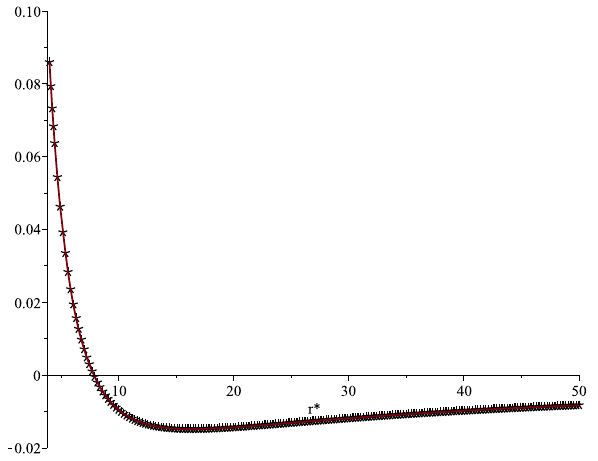
Fig. 9 Plot of the effective potentials (28) (asterisk symbol) (Schwarzschild case) and (30) (solid line) in the massive case when L = 3, H = 0 . 1 and ξ = 1 . 0. This choice of H gives rise to a scaling factor h of the same order as h B 1 = 3 . 89 × 10 − 11 kpc in √ = 9 + 3 [58]. The minimum is located at r ∗ 6 ≈ 16 . 35 where min ) = − 0 . 0147 and V ( r ∗ ) = − 0 . 0147. Both potentials V ef f , S ( r ∗ ef f min min share the same minimum and V ef f , S is a good approximation of V ef f in a neighbourhood of the minimum and asymptotically away